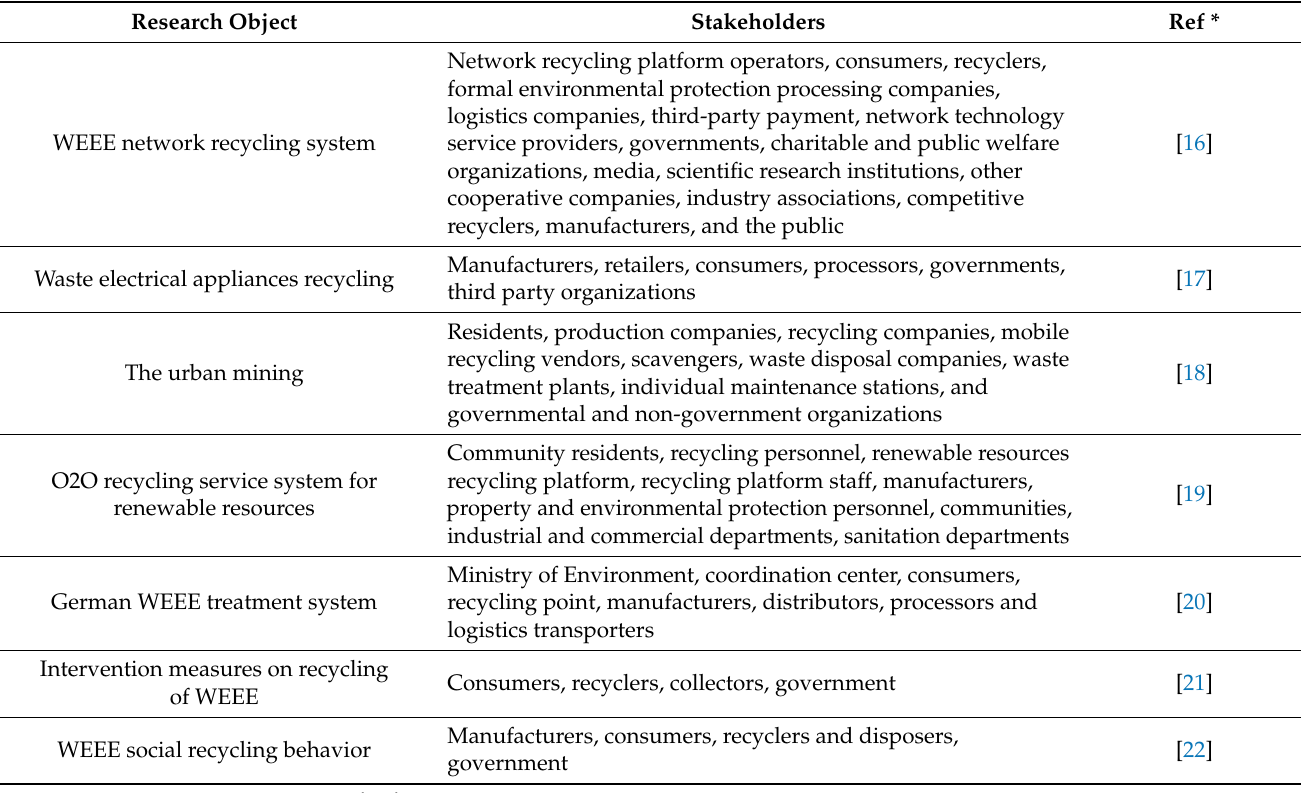
Table 1. Global stakeholder study sheet on Internet recycling of electronic